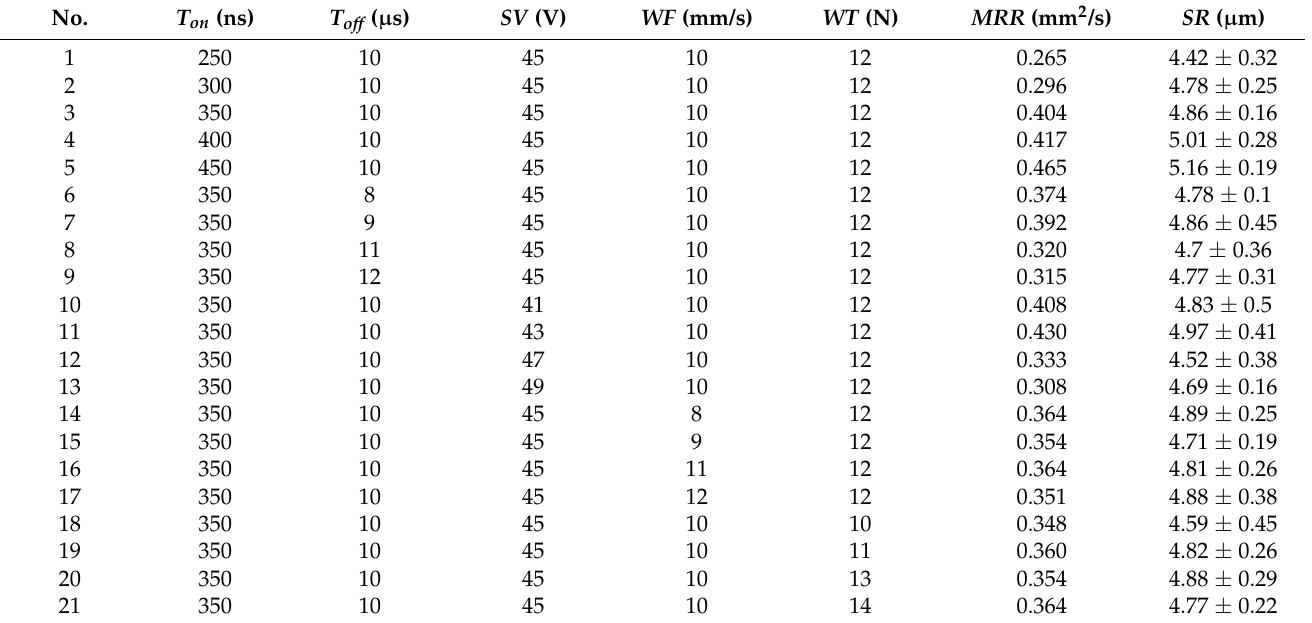
Table 4. The results of discharge cutting